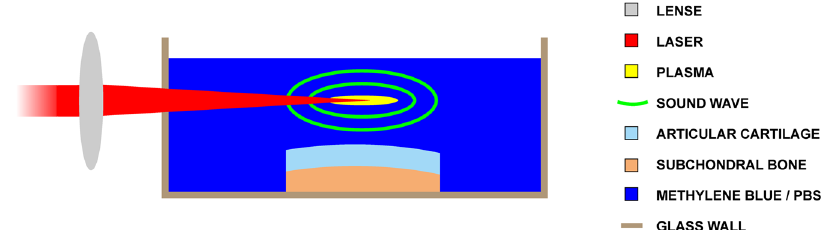
Figure 2. Experimental setup. Articular cartilage (AC) sample with subchondral bone was placed into a glass container filled with immersion fluid (methylene blue in PBS or PBS only). Laser beam ( λ = 1064 nm) was focused 3 mm above the AC surface. Ultrasound pulse was generated from a minute plasma spark at the optical focus following a 8 ns laser pulse (Q-switch delay = 300 µ s, pulse energy = 130 ± 10 mJ). One treatment consisted of 2000 sound pulses at 3 Hz pulse repetition frequency yielding a treatment time of 11.1